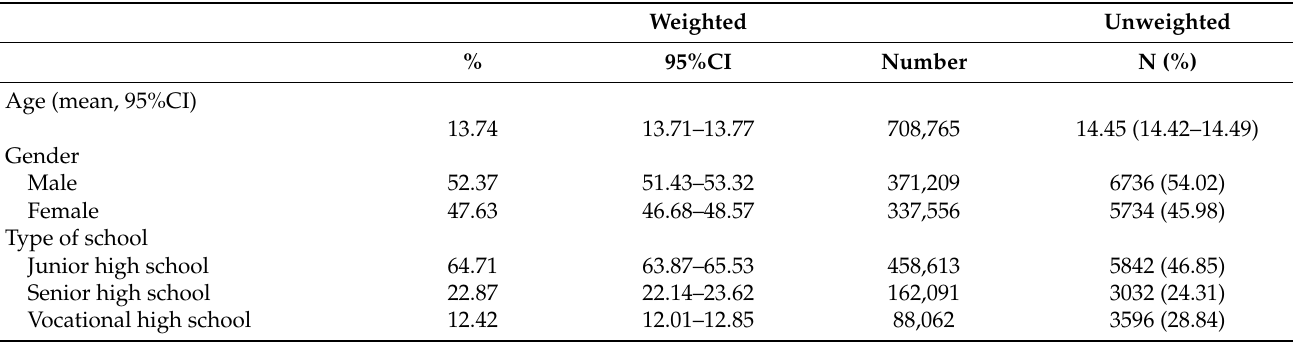
Table 1. Baseline characteristics (N =